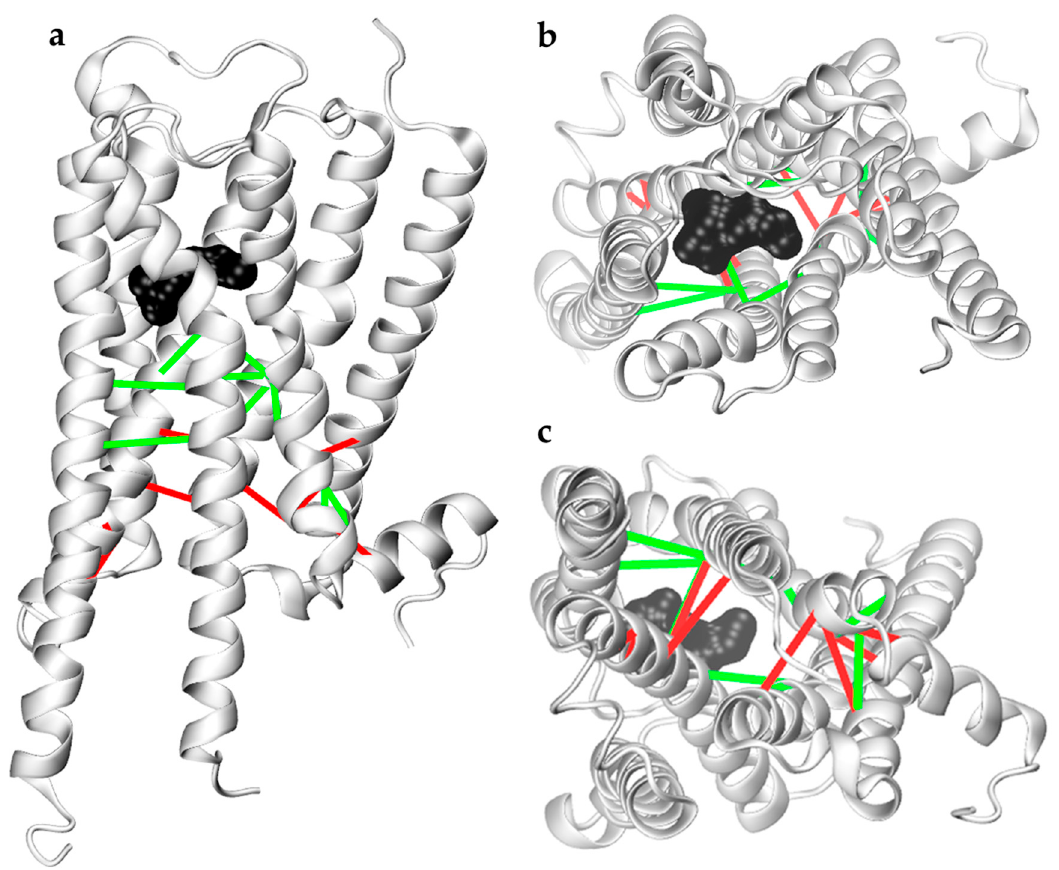
Figure 4. Contacts between key residue pairs involved in the first stage of M1 receptor activation discussed in this paper. ( a ) Side, ( b ) top, and ( c ) bottom views of M1 are shown with distances that increase (green) and decrease (red) upon activation, represented by lines. IR3535 is shown in black surface representation to indicate the position of the orthosteric binding